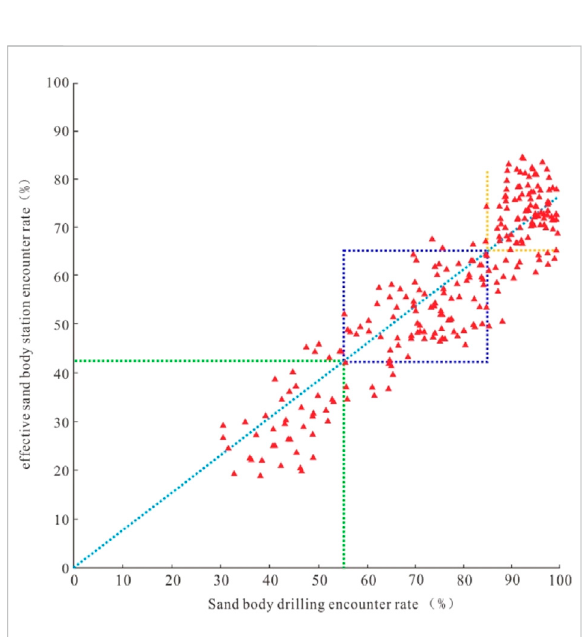
FIGURE 8 Intersection diagram of sand body drilling encounter rate effective sand body station encounter